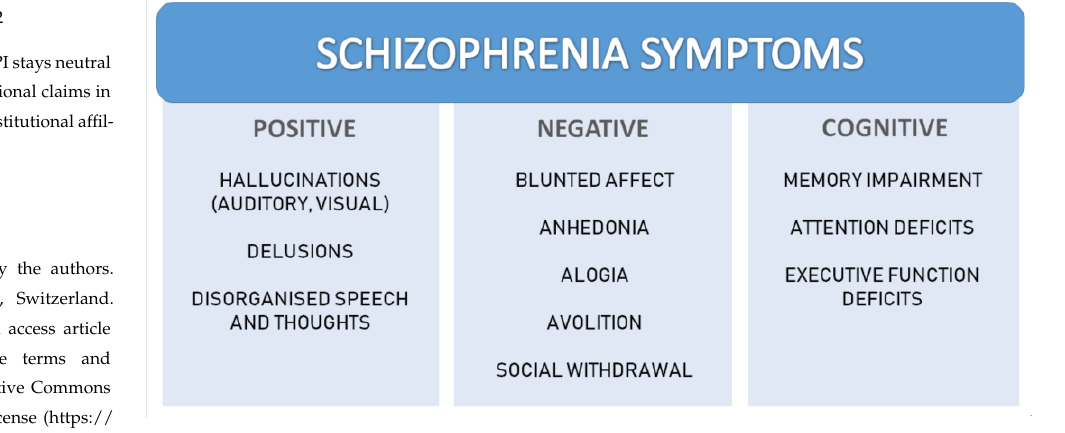
Figure 1. Schizophrenia